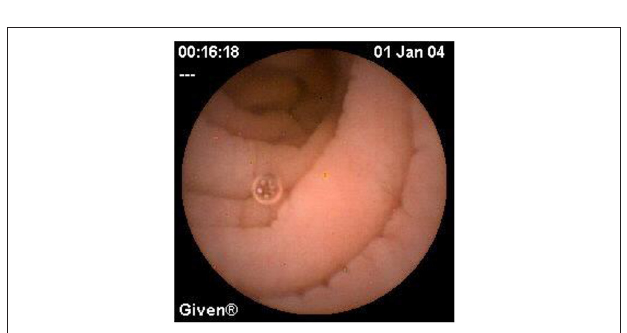
FIGURE 12 | Celiac scalloping distally (with normal EGD).